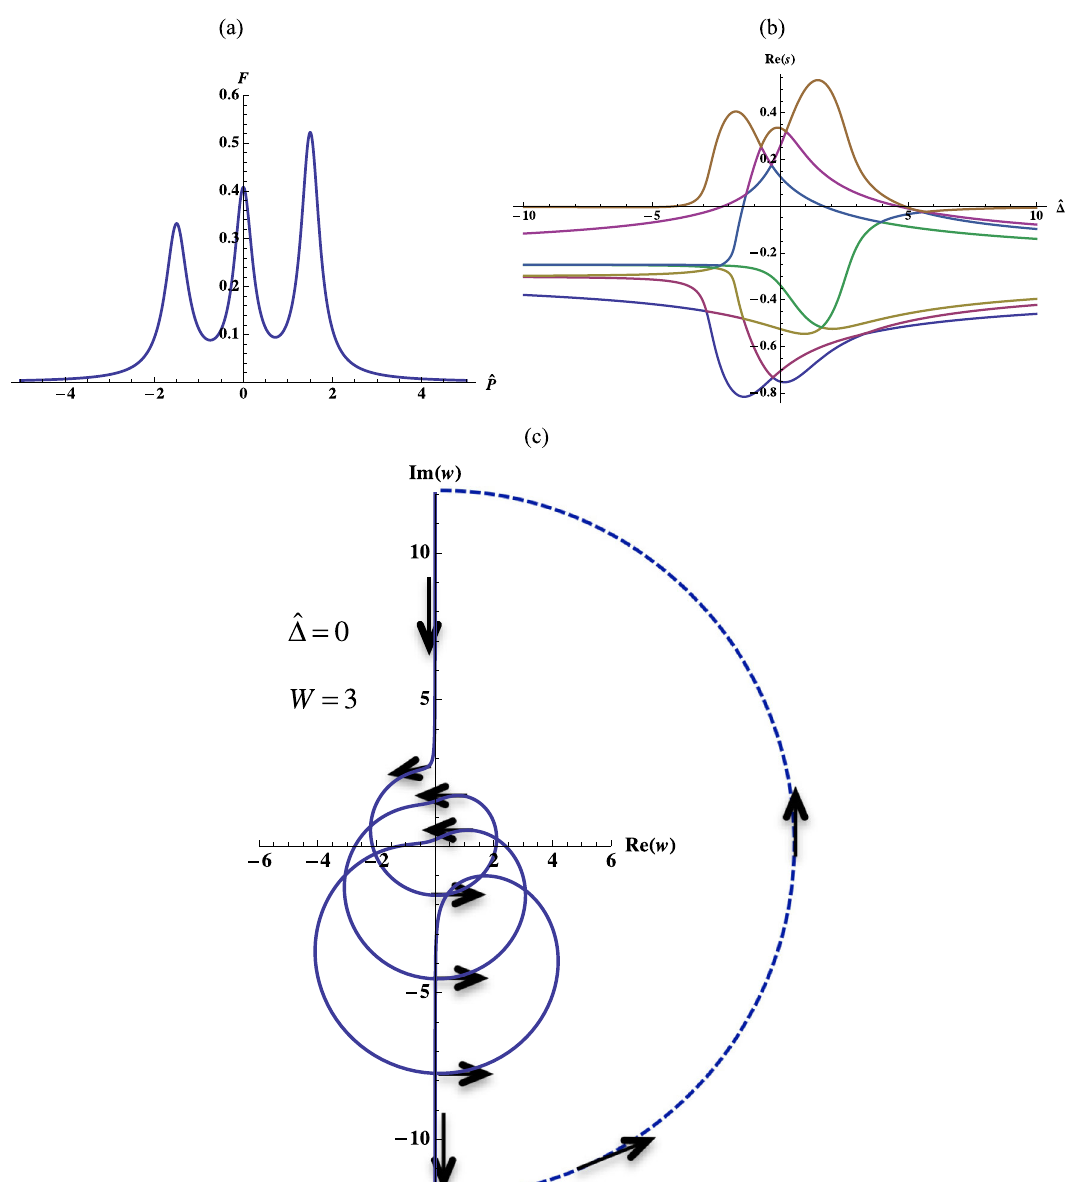
FIG. 10. (a) Tri-Lorentzian energy distribution. (b) Real parts of seven roots of the dispersion relation as functions of the detuning. (c) Contour of w ð C Þ (with scaled down semicircle) for zero detuning ^(cid:2) ¼ 0